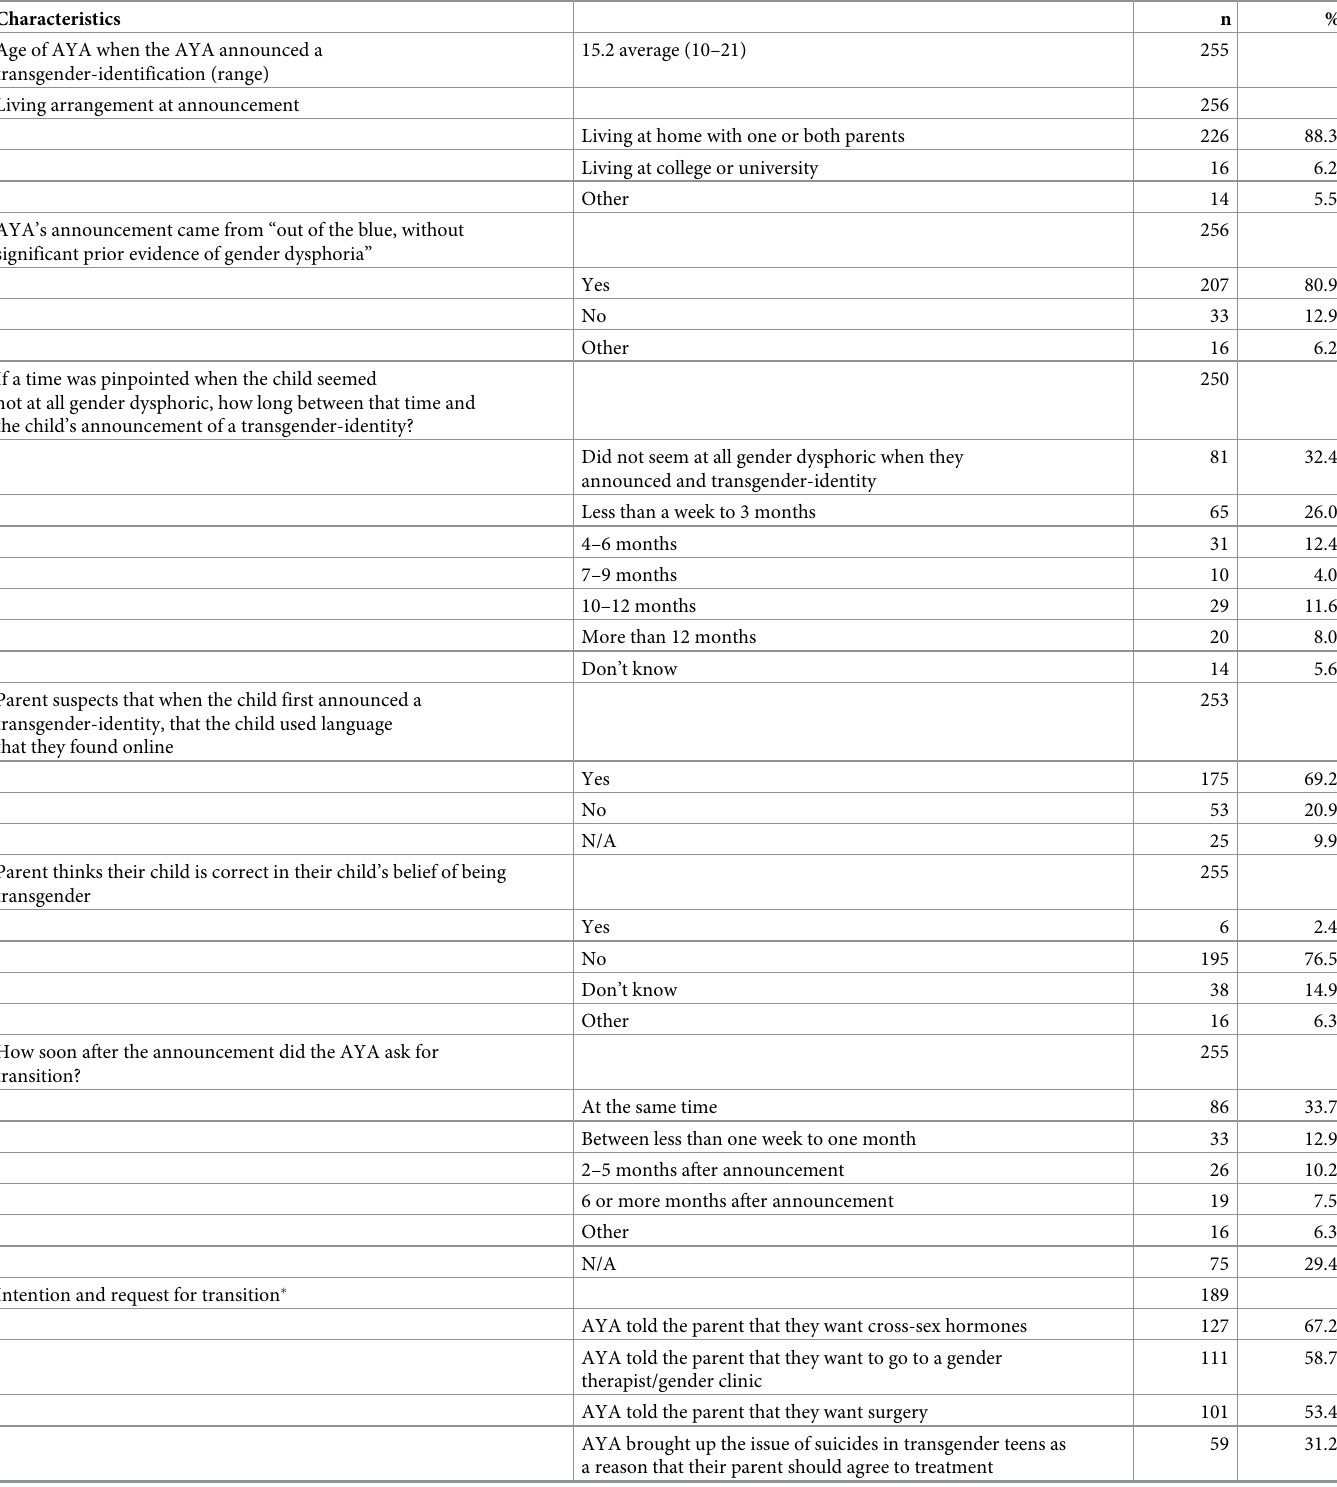
Table 5. Announcing a transgender-identification.